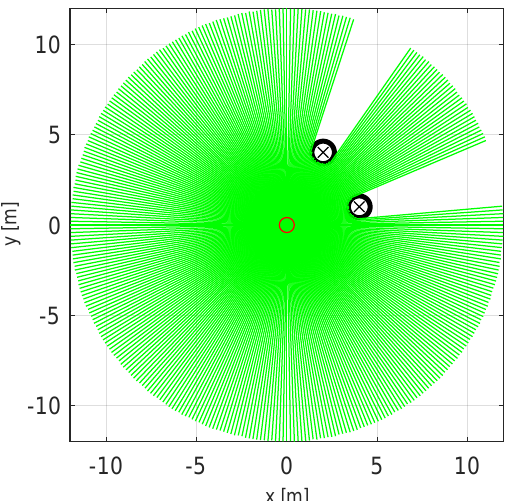
Figure 3. LiDAR sensor data simulation from the workspace of the agent. The agent is in the origin, represented by the red circle, there are two obstacles in the workspace, represented by black circles, and the estimated positions of the obstacles are shown by black x − s. The maximum range of the LiDAR sensor is 12 m, and the resolution is 0.5 ◦